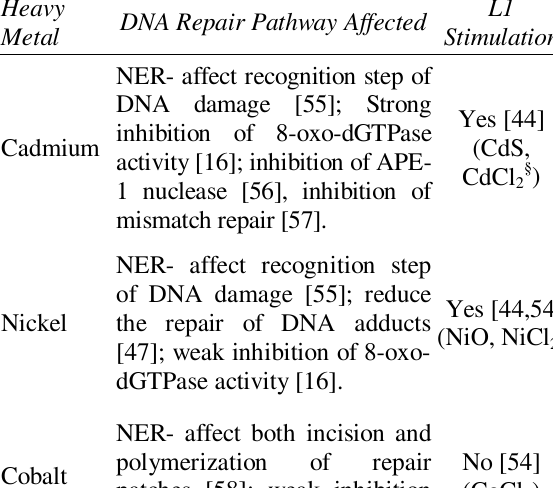
Table 1: Effects of different metals on DNA repair pathways and L1